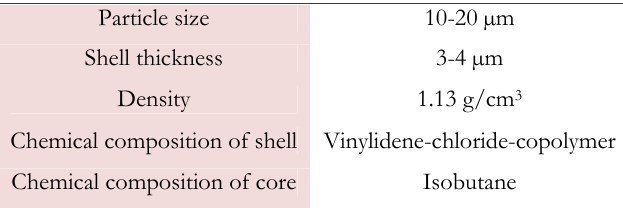
Table 1: Characteristic of the TEMs (F-30D) used in the present study.